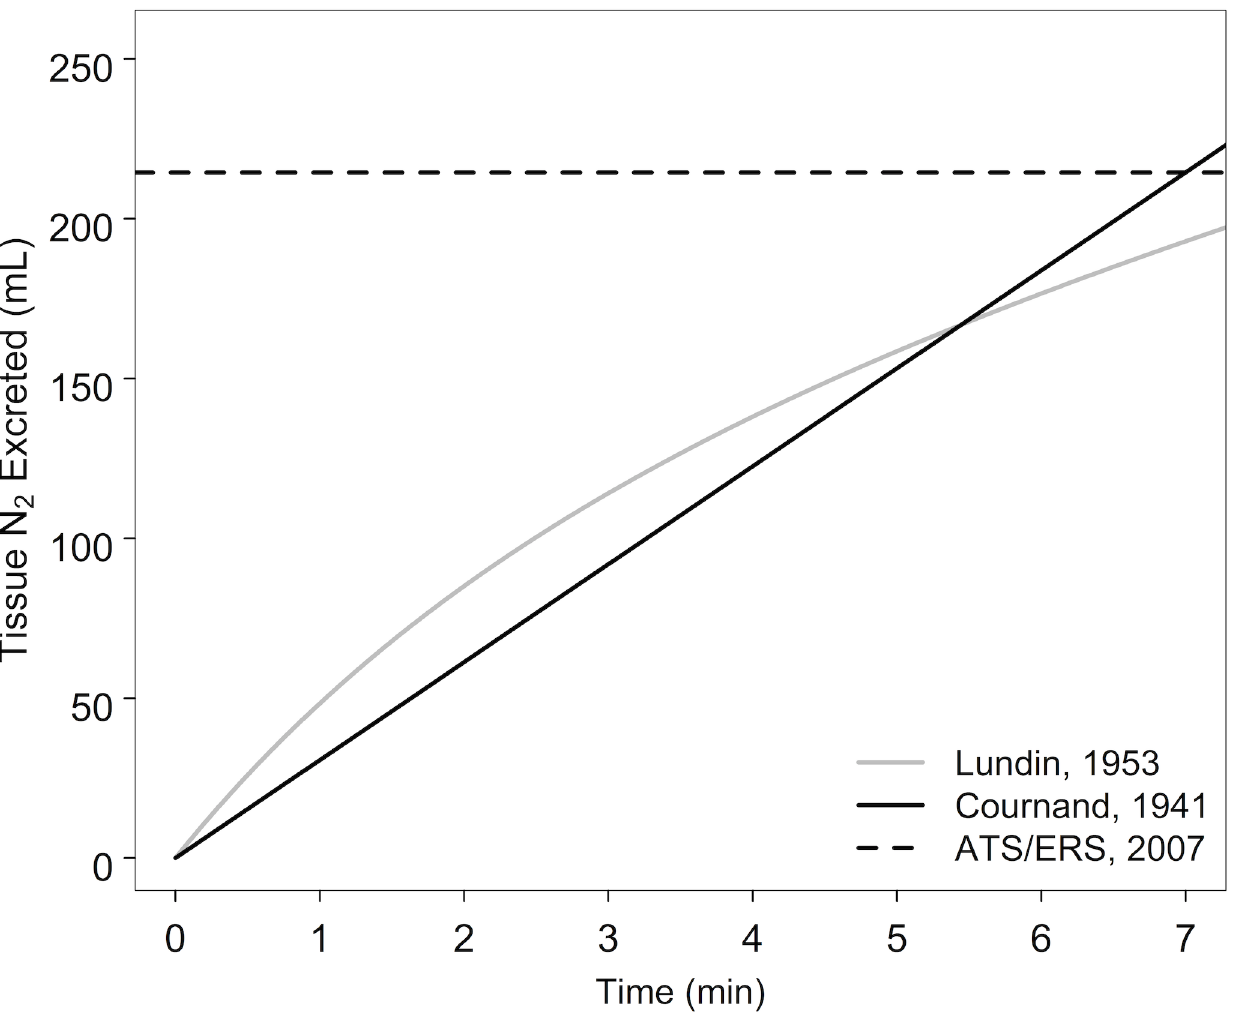
Fig 1. Tissue N 2 excretion equations used for correction of MBW N2 measurements. The three equationsused to estimate the volume of N 2 excreted from the body tissues are plotted over a 7 minute time period. The Cournand 1941 equationwas adjustedfor a constant excretion rate and plotted for a subject with the averagebody size of the subjects measuredin the Lundin1953 study. The ATS/ERS equation calculates the volume of tissue N 2 excreted using Cournand’s 1941 equationstandardized to a 7 minute washout for all subjects.